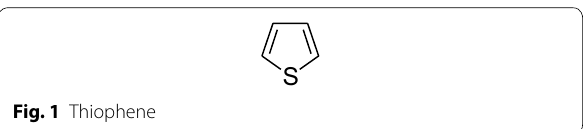
Fig. 1 Thiophene